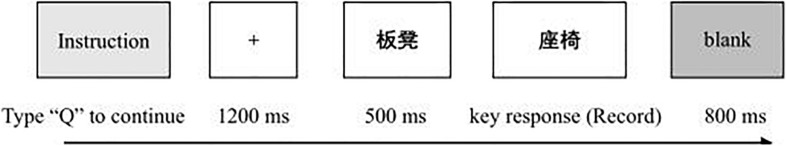
Example of a trial in Experiment 1.